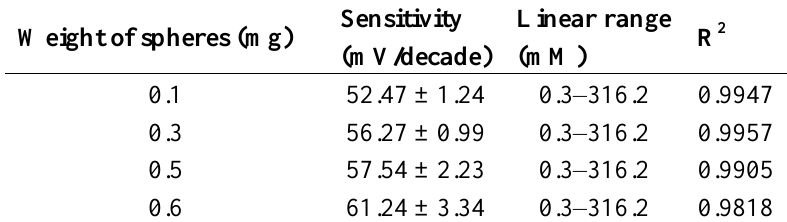
Table 4. The effect of total amount of poly(nBA-NAS) microspheres with immobilized AOX towards the formaldehyde biosensor